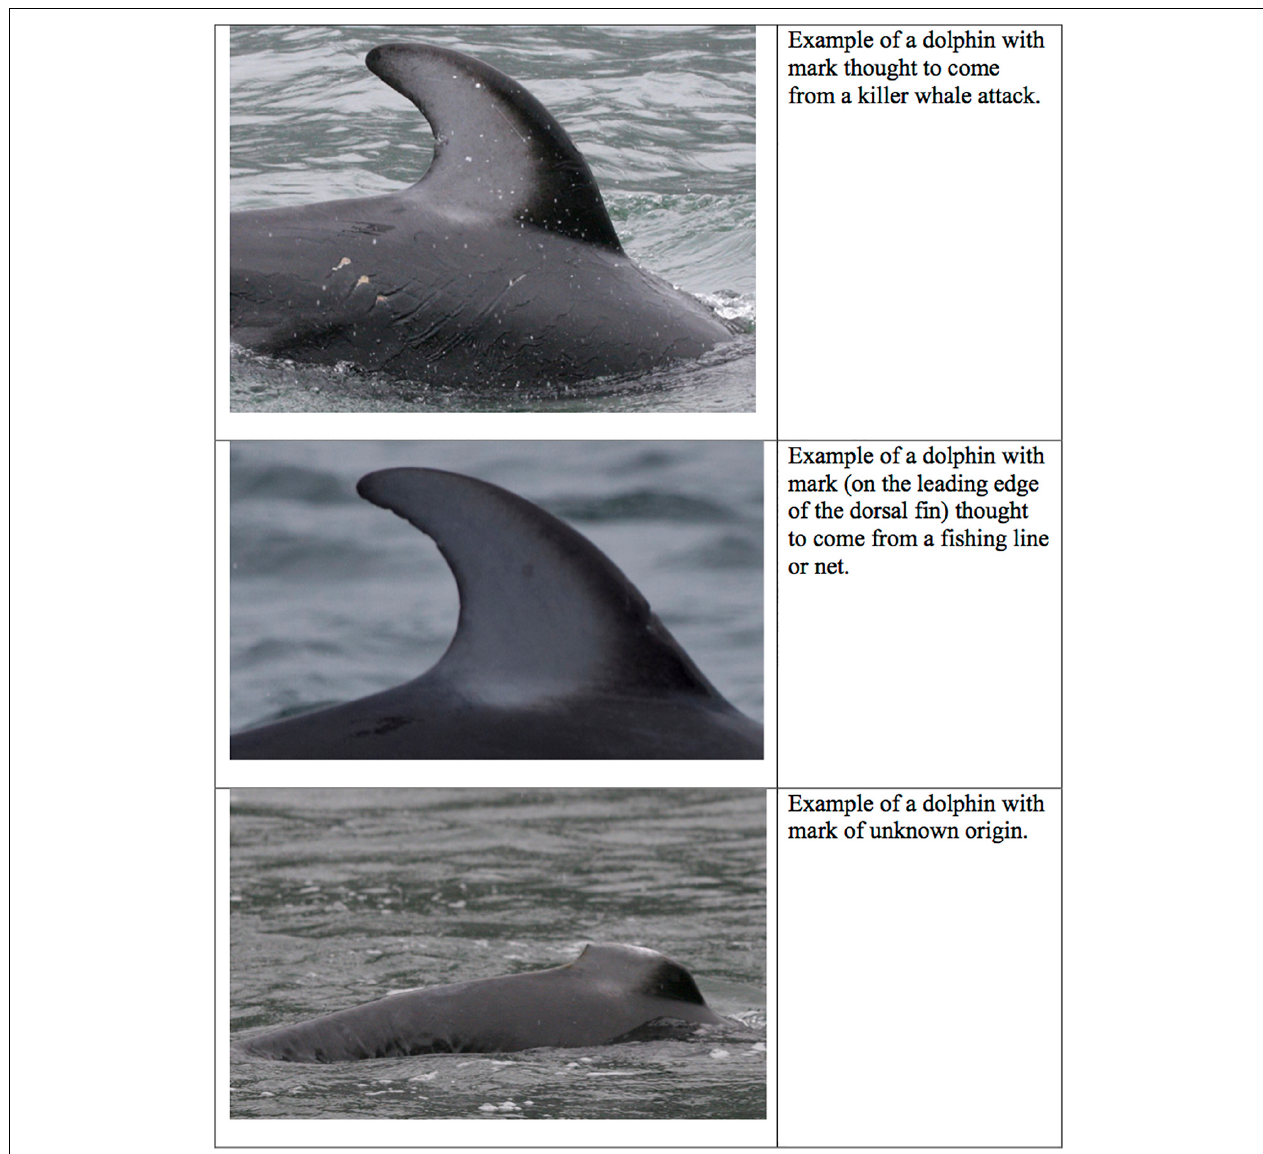
FIGURE 1 | Examples of the three types of photos included in the marine mammal injury expert survey: injuries thought to be caused by (1) killer whales, (2) human activities, and (3) unknown origin. Responses from experts were used to guide subsequent categorization of injuries for the well-marked Pacific white-sided dolphins in the complete digital photo-ID catalog.